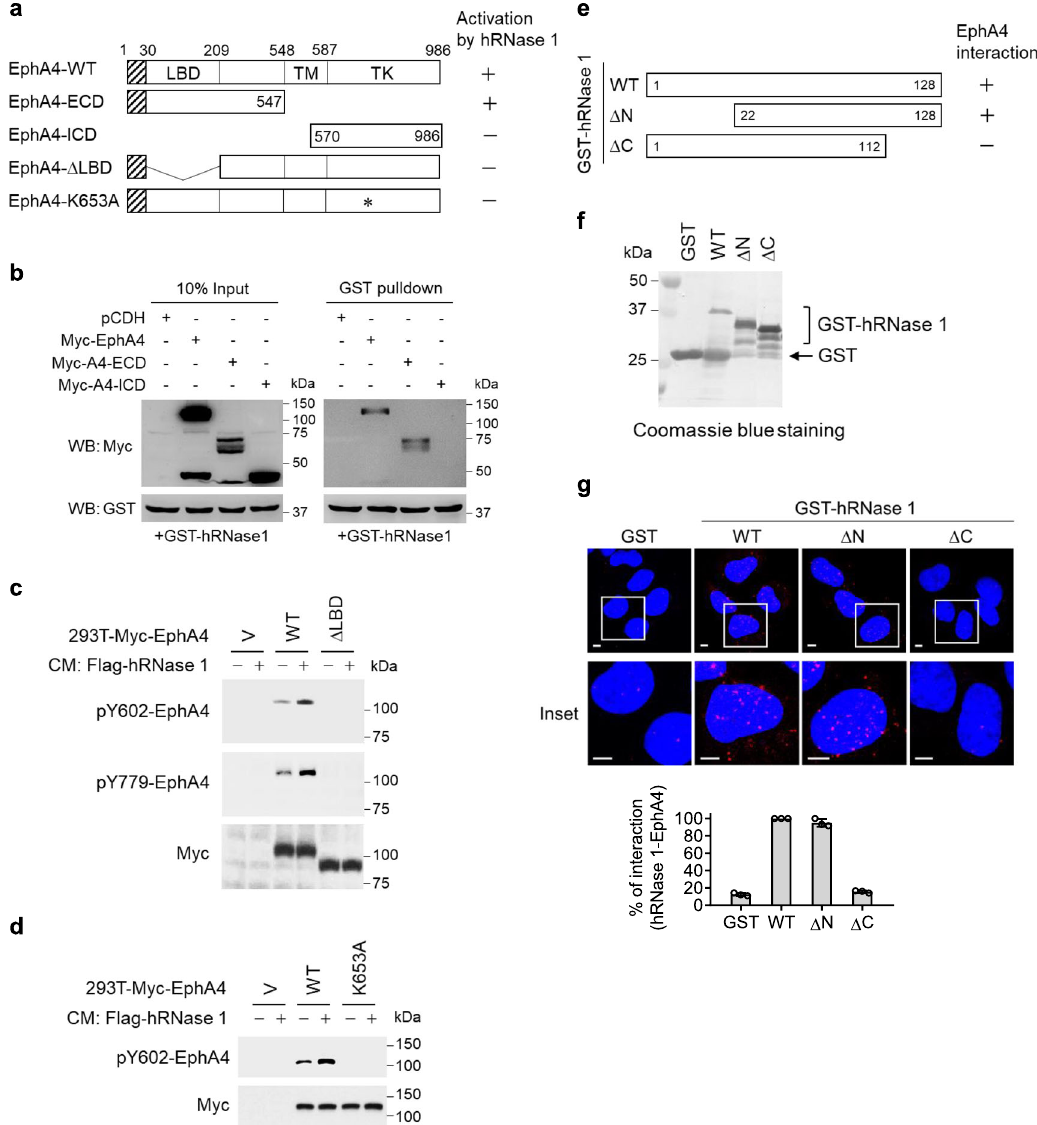
Fig. 4 hRNase 1 binds to EphA4 ligand-binding domain and binding requires its C-terminus. a Schematic diagram of various constructs of Myc-tagged EphA4. The numbers represent amino-acid residues. EphA4-ECD, amino acids 1 – 547 of EphA4; EphA4-ICD, amino acids 570 – 986 of EphA4; *, EphA4- K653A, mutation of EphA4 phosphorylation site. b In vitro GST pull-down assay of GST-tagged hRNase 1/glutathione magnetic beads incubated with lysate from 293T transfected with the indicated expression plasmids, including WT, ECD and ICD of EphA4, and pCDH empty vector, followed by three times of PBS washing. Left, input lysates. c , d WB of 293T stable transfectants generated by constructs of ( a ) or empty vector (V) treated with or without CM collected from 293T stable transfectant containing hRNase 1 for 30 min. e Schematic diagram of various constructs of GST-tagged hRNase 1. f Coomassie blue staining of GST-hRNase 1 plasmids as indicated. The 26 kDa GST band is a product of GST-hRNase 1 degradation. g Duolink in situ PLA of KPL4 cells expressing EphA4 and hRNase 1 knockout (KPL4-A4-KO-R1) treated with GST vector or GST-hRNase 1 proteins from ( f ) for 30 min. Insets, 6.25× magni fi cation. Bar, 5 µ m. Bar diagram indicates the percentage of cells showing positive hRNase 1 and EphA4 interaction calculated from a pool of 50 cells; error bars represent mean ± SD, n = 3 independent experiments. Data in ( b – d , f ) are representative of two independent experiments with similar results. Source data are provided as a Source Data fi